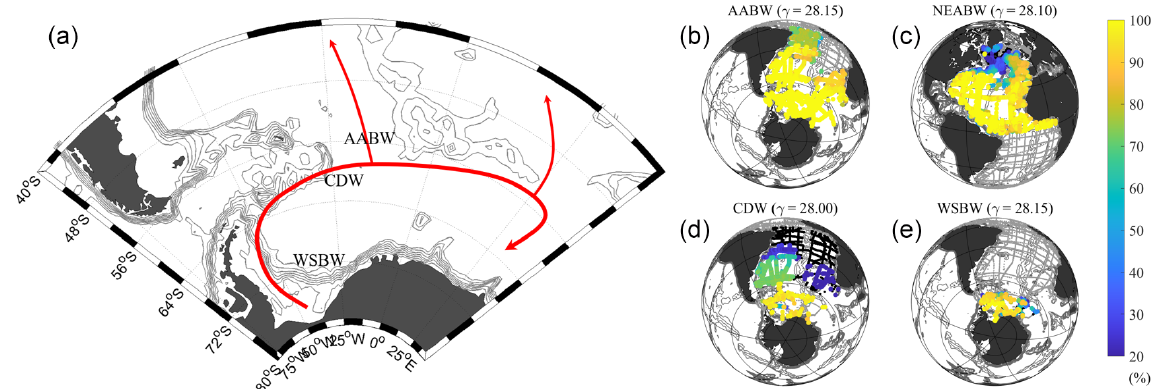
Figure 15. Currents (a) and water masses (b, c, d, e) in the bottom layer (AABW and NEABW) and the southern area (CDW and WSBW). (a) The arrows show the main currents in the southern area. (b, c, d, e) The coloured dots show fractions (from 20% to 100%) of water masses in each station around core neutral density (kgm − 3 ). Stations with fractions less than 20% are marked by black dots, while grey dots show all the GLODAPv2